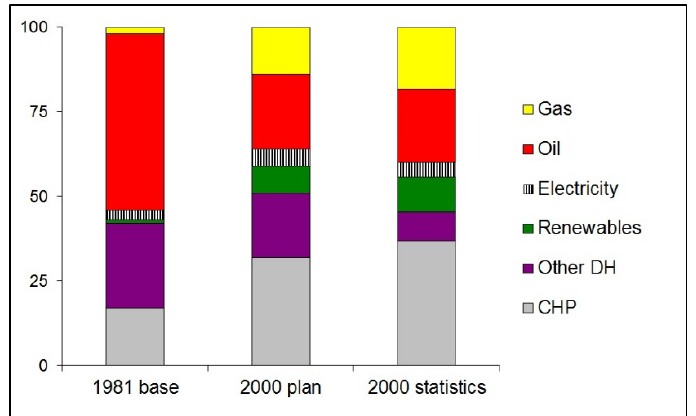
Figure 9. Heat sources in Danish households: Columns from left to right: 1. Year 1981 base. 2. Year 2000 model results made in the 1980s. 3. Year 2000 statistics. Source: [80].